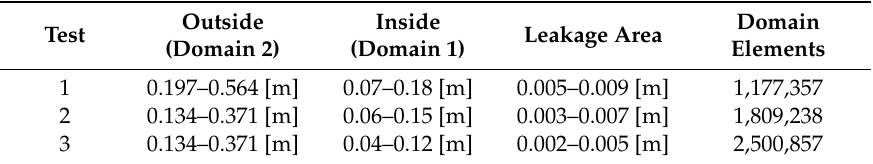
Table 4. List of initial conditions inside and outside the enclosure taken for modeling. Table 3. List of mesh sizes and elements for